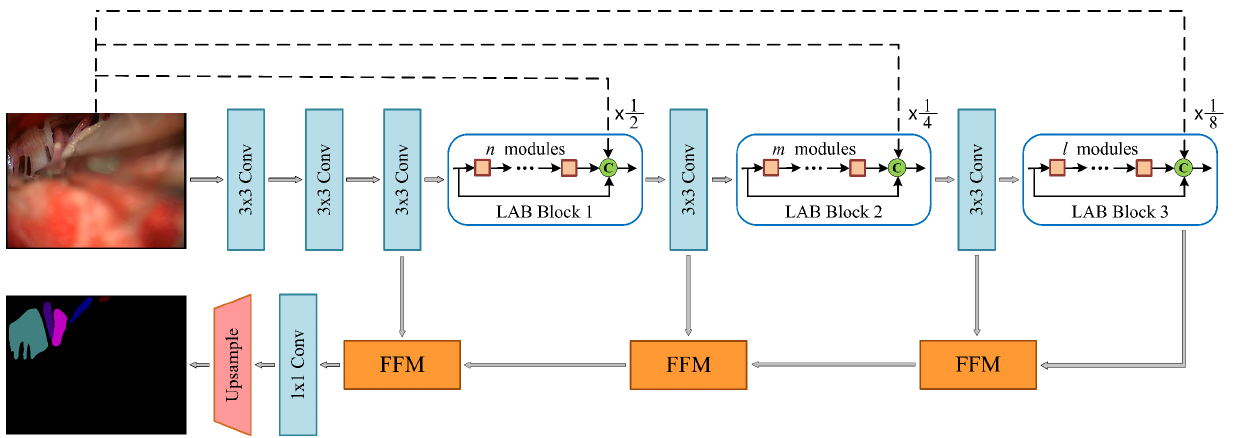
Figure 4. Architecture of the proposed MVDNet. C: concatenation; dashed lines indicate average pooling operations.